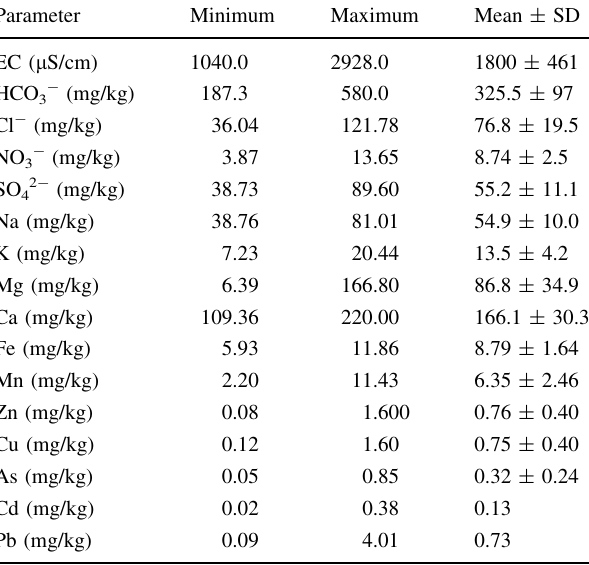
Table 1 Characteristics of shallow aquifer soil samples